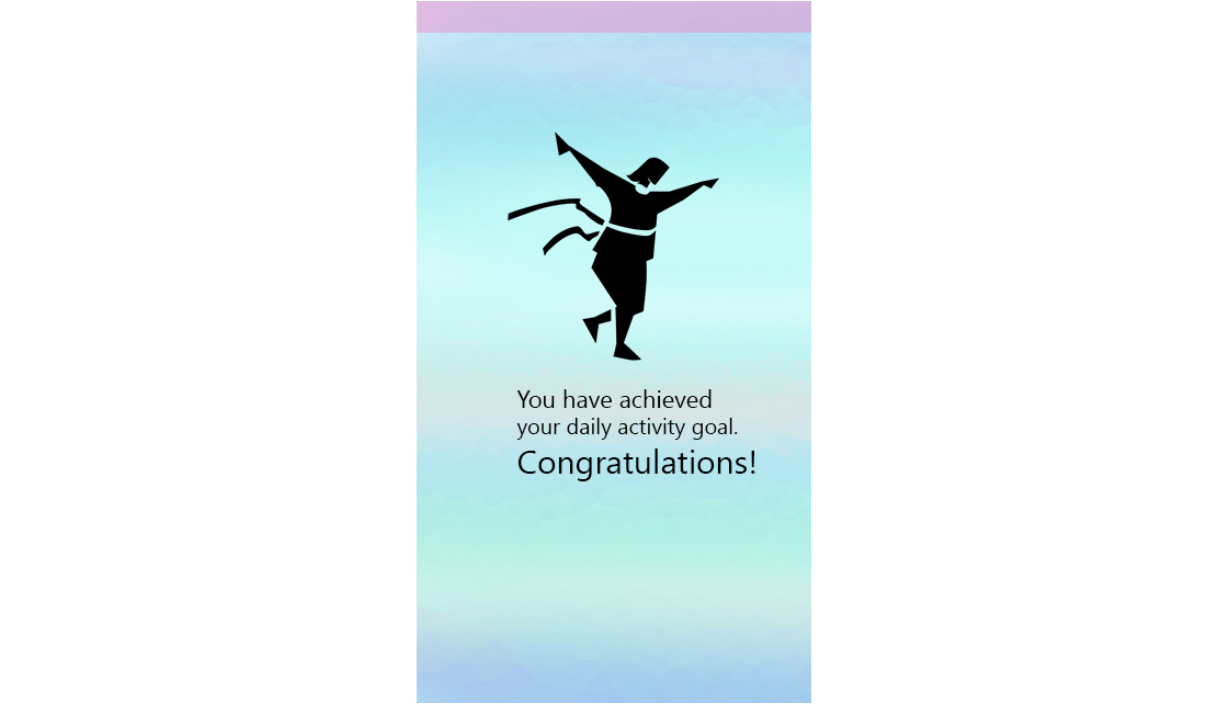
Figure 2. Example of graphic user interfaces of interventions (congratulatory message for achieving goal).